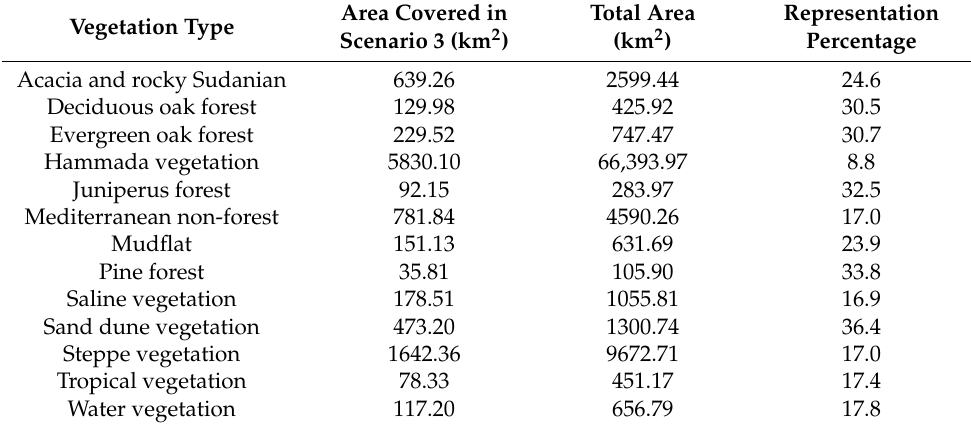
Table 8. The representation percentage of each vegetation type in solution for scenario 3. Area Covered Vegetation Type